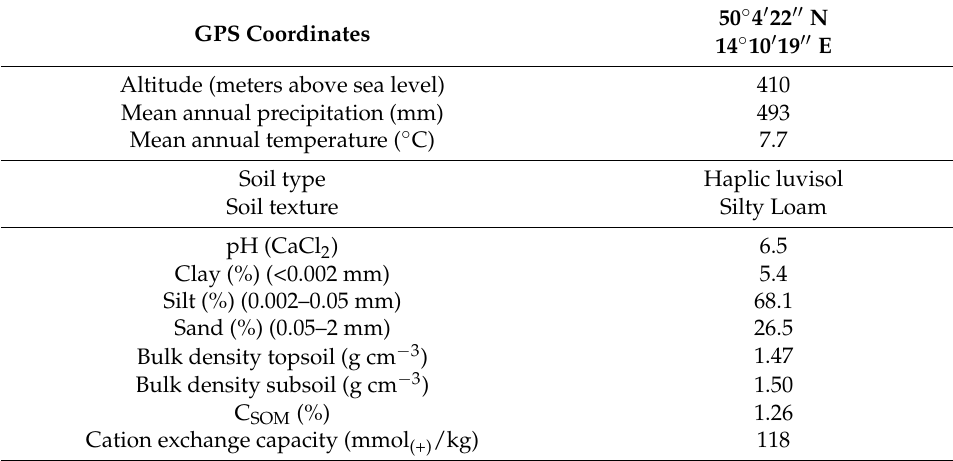
Table 1. Experimental site characteristics.